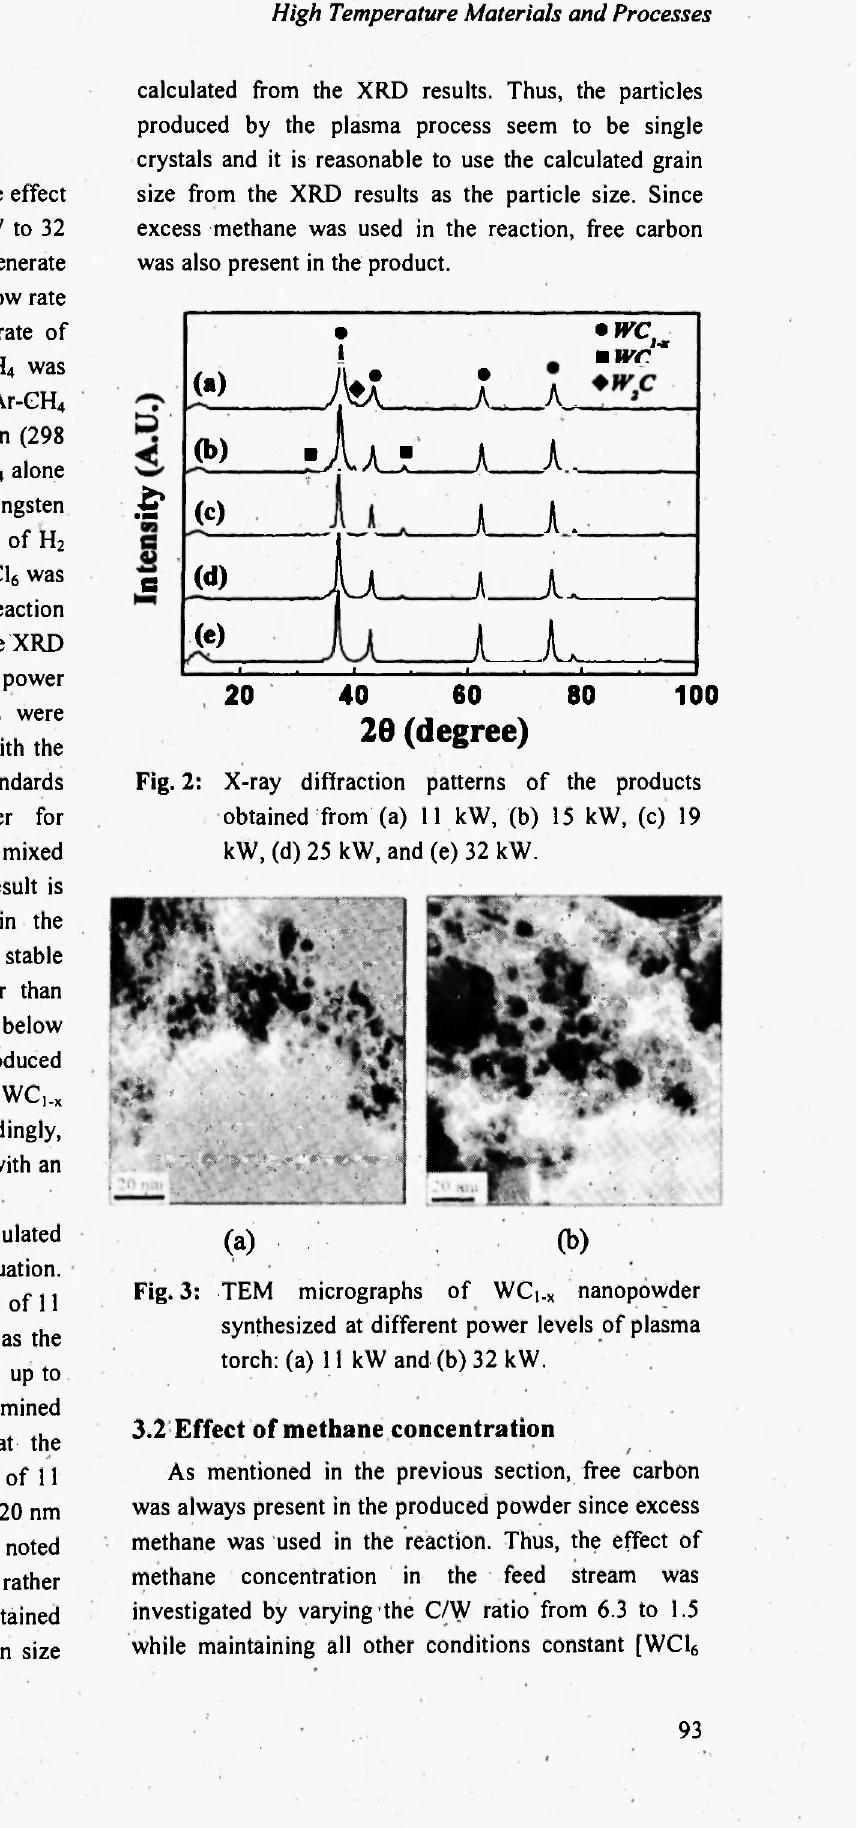
Fig. 3: TEM micrographs of WC). X nanopowder synthesized at different power levels of plasma torch: (a) 11 kW and (b) 32